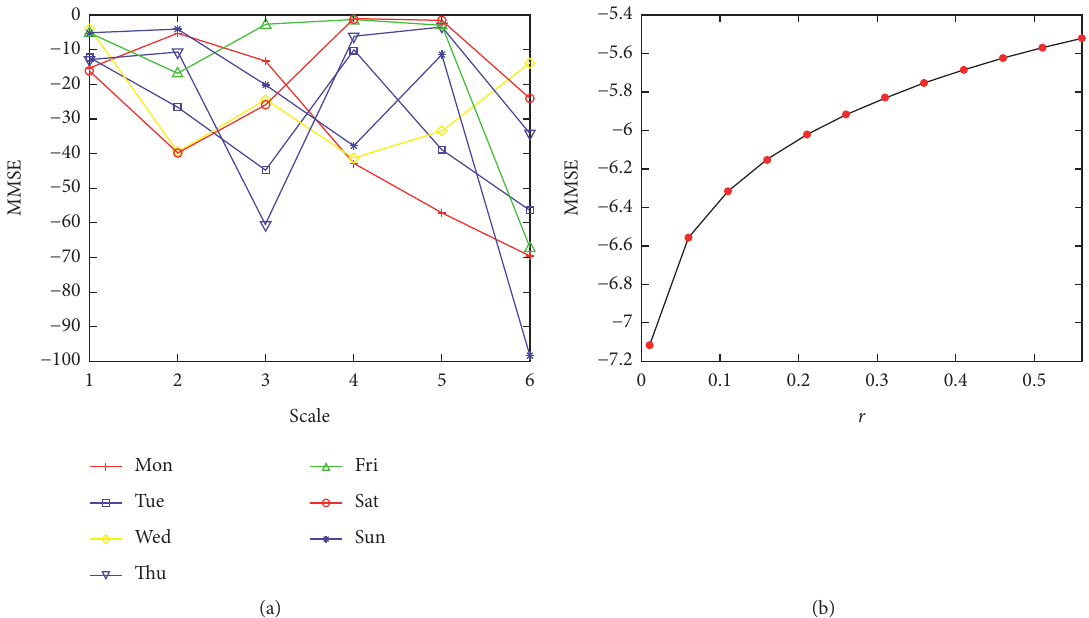
Figure 3: The analysis result of the traffic data using MMSE. (a) The analysis of the traffic data using MMSE. (b) The MMSE of Monday versus various scales under different r